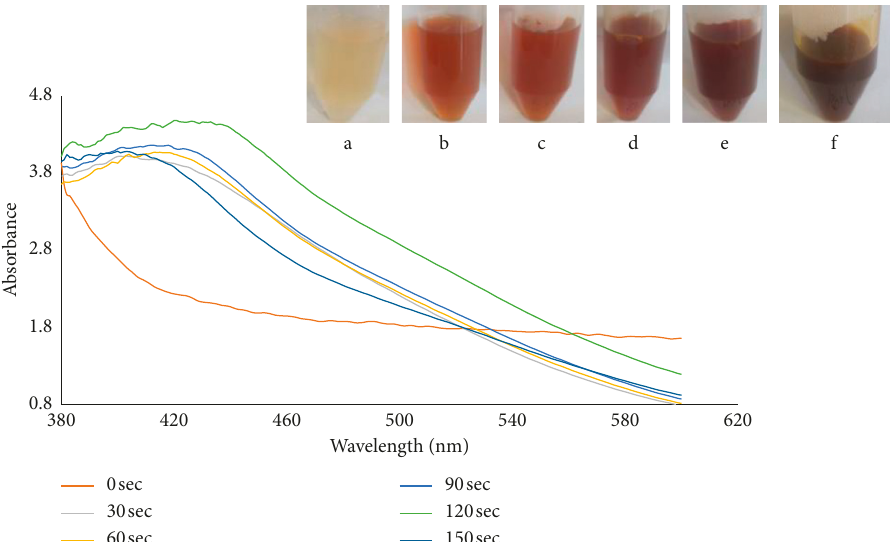
Figure 1: UV-visible spectra and photographic representation of silver nanoparticles biosynthesized by using aqueous C. paradisi peel extract at the mixing ratio of 2 :3 at different time intervals.